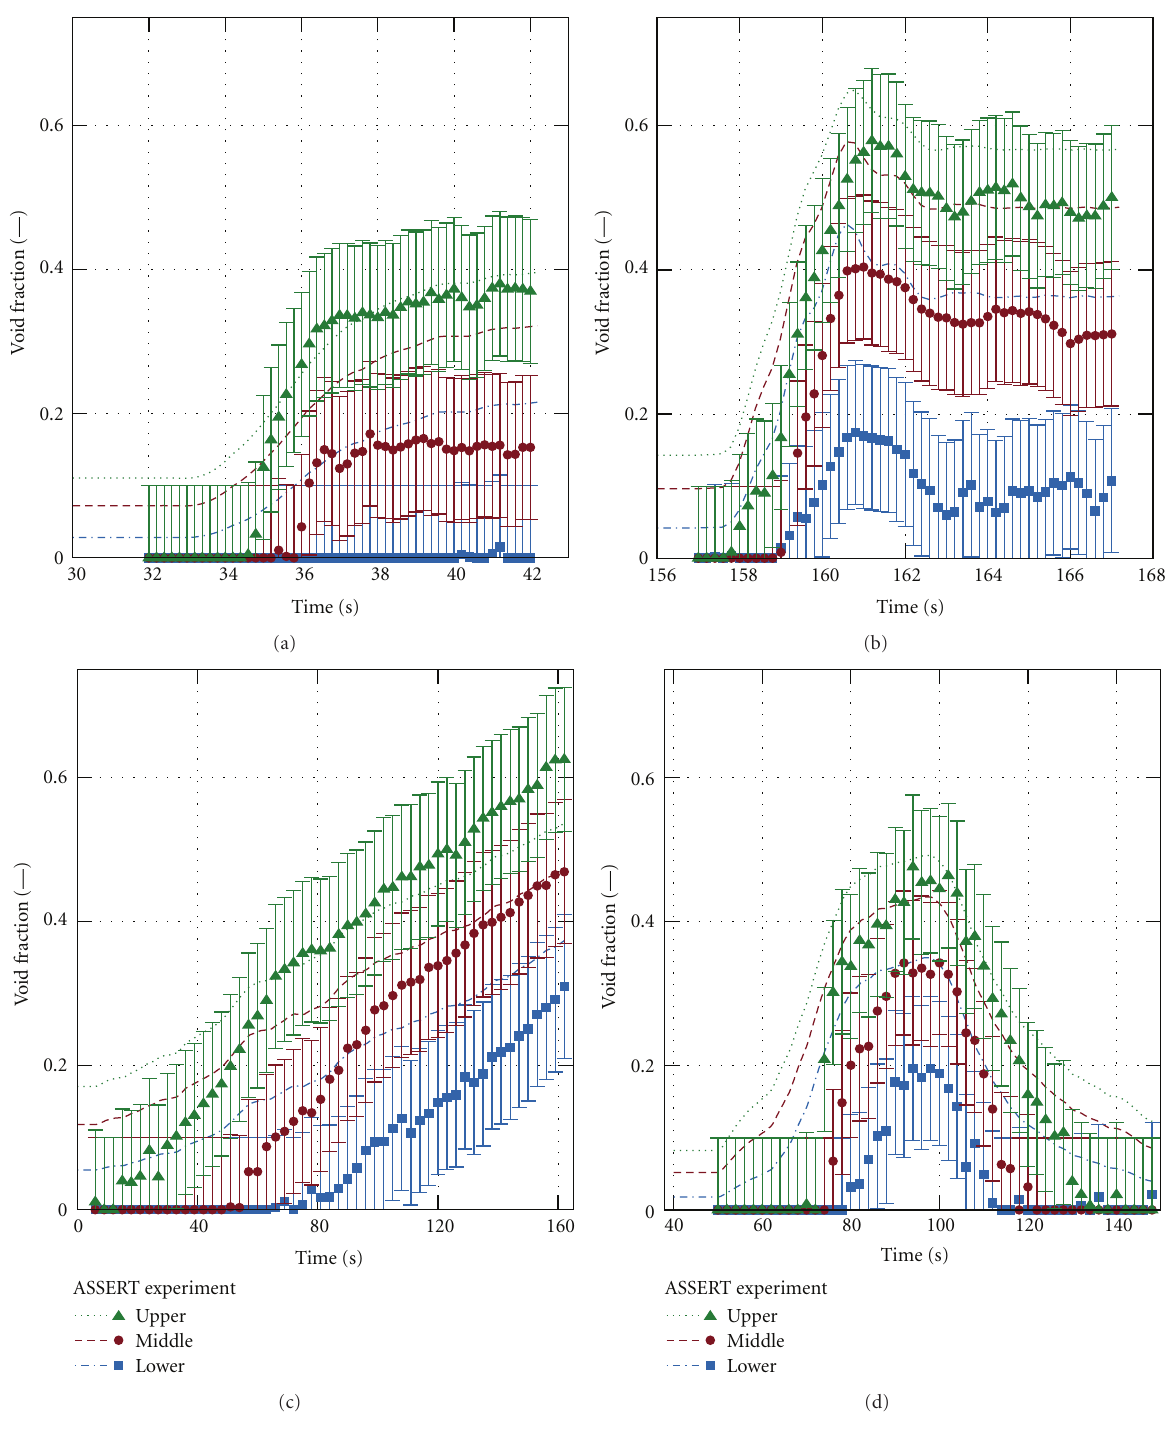
Figure 15: Transient void fraction results for bundle test series B7. Power increase (a), flow reduction (b), depressurization (c), and inlet temperature increase (d). Error bands displayed correspond to 2 σ exp = 0 .